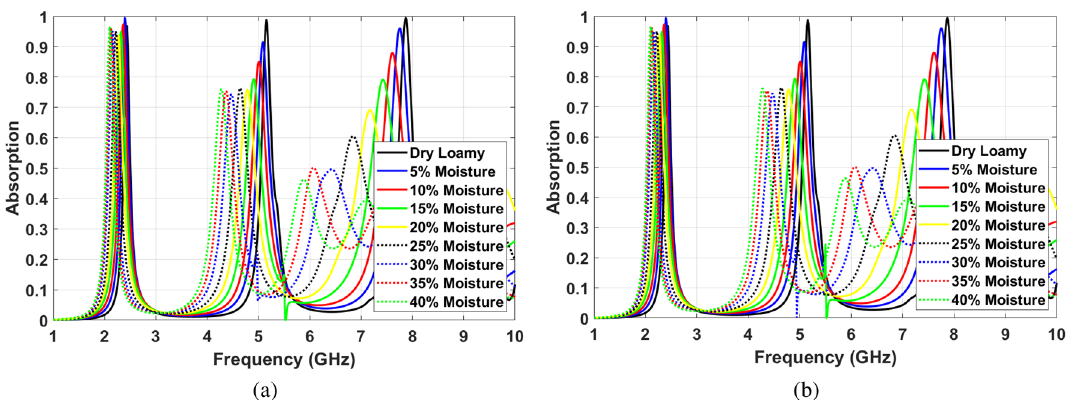
Figure 13. Sensing efficiency of the proposed MPA for different moisture levels in Loamy soil ( a ) Facing TE polarized incident waves, ( b ) Facing TM polarized incident